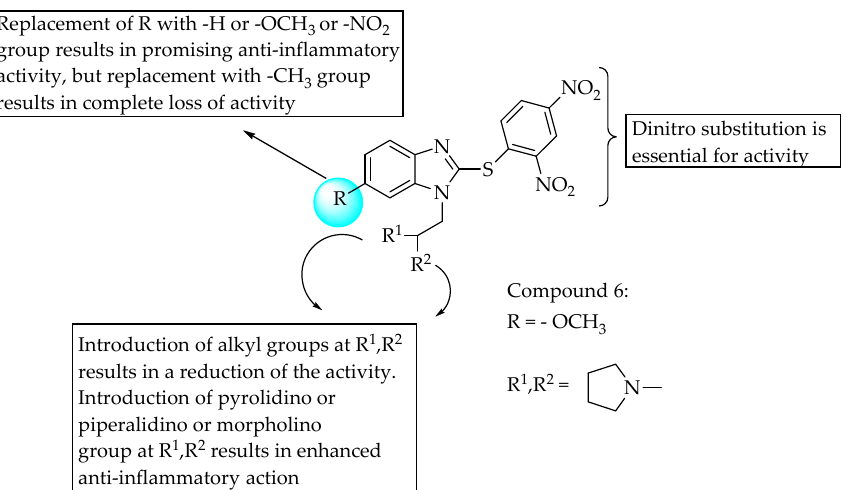
Figure 28 . SARs of N-Mannich bases of substituted 2-mercapto-1H-benzimidazoles. Figure 28. SARs of N-Mannich bases of substituted 2-mercapto-1 H -benzimidazoles.